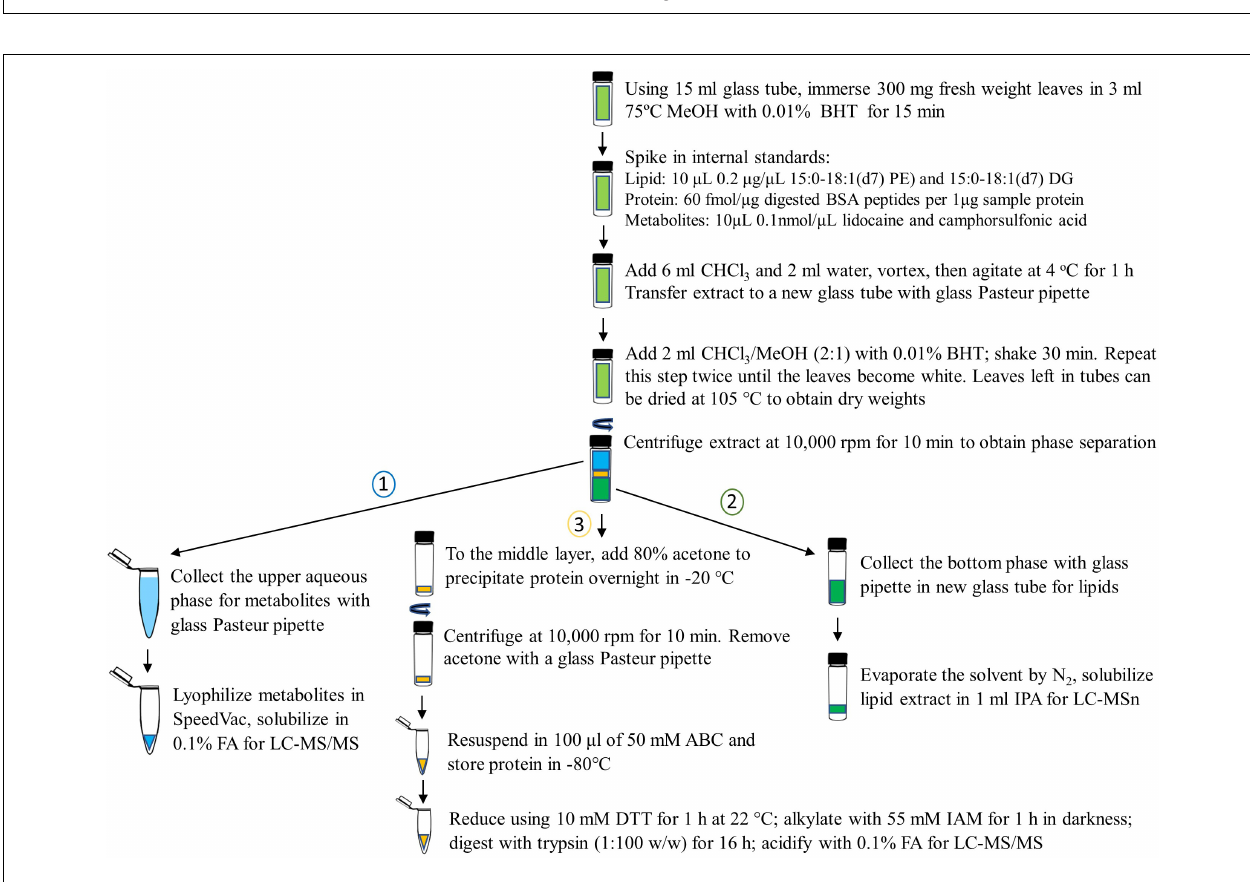
FIGURE 2 | Detailed workflow of 3-in-1 sample extraction of proteins, metabolites, and lipids from control and primed Arabidopsis leaves. A chloroform/methanol/water extraction is used to separate the three fractions and each layer is carefully isolated using supplies of glass materials to avoid plastic contaminants in samples. The order of fractionated is important and labeled. Butylated hydroxytoluene (BHT) is added at the start of the extraction to avoid oxidation of lipids during the procedure. MeOH, methanol; PE, phosphatidylethanolamine; DG, diacylglycerol; BSA, bovine serum albumin; CHCl 3 , chloroform; FA, formic acid; LC-MS/MS, liquid chromatography tandem mass spectrometry; IPA, isopropanol; ABC, ammonium bicarbonate; DTT, dithiothreitol; IAM, iodoacetamide.